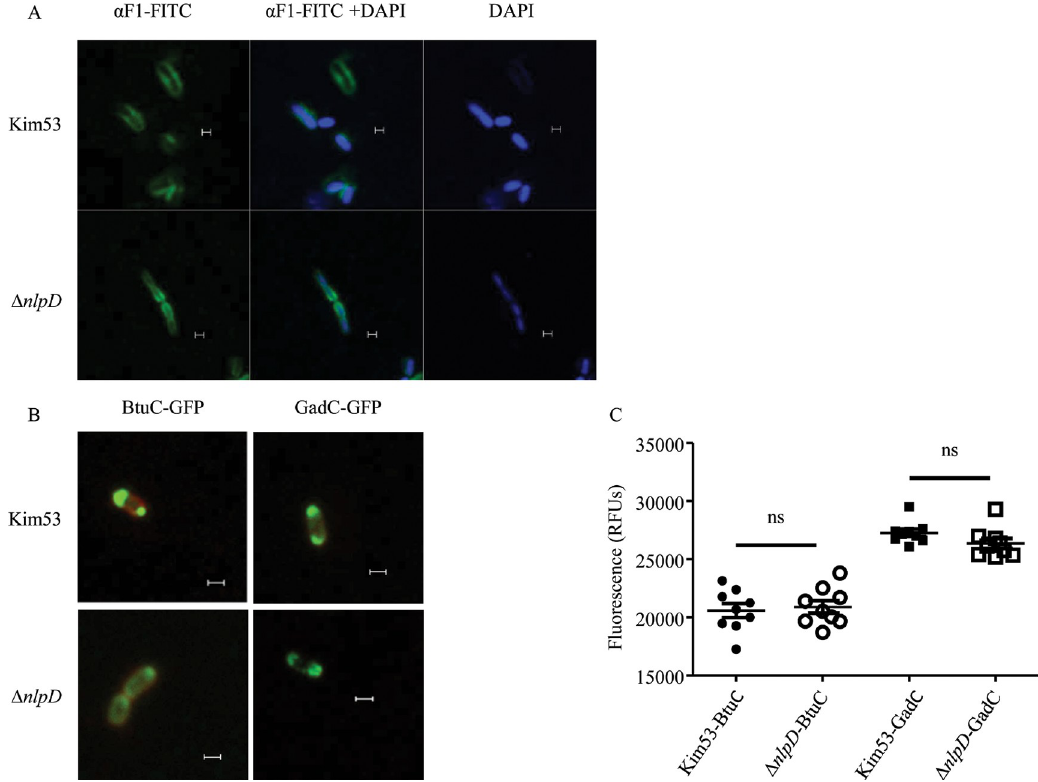
Fig 4. The Sec translocon is operational in the Δ nlpD mutant. A. The indicated bacterial cells were labeled with FITC- conjugated α -F1 antibodies (left), DAPI (right) or both α -F1 and DAPI (middle). B. Fluorescence microscopy of Y . pestis strains expressing the Sec-substrates BtuC and GadC fused to GFP. Scale bar = 1 μ m. C. Relative fluorescence units (RFUs) of the Δ nlpD mutant expressing BtuC-GFP or GadC-GFP, compared to the wild Kim53 strain expressing the reporter proteins, according to [40]. Ns, non-significant (Unpaired t test). The data presented are representative of at least two independent experiments and the displayed data in A and B is one representative